Question: According to the figure, is the described quantity increasing or decreasing?
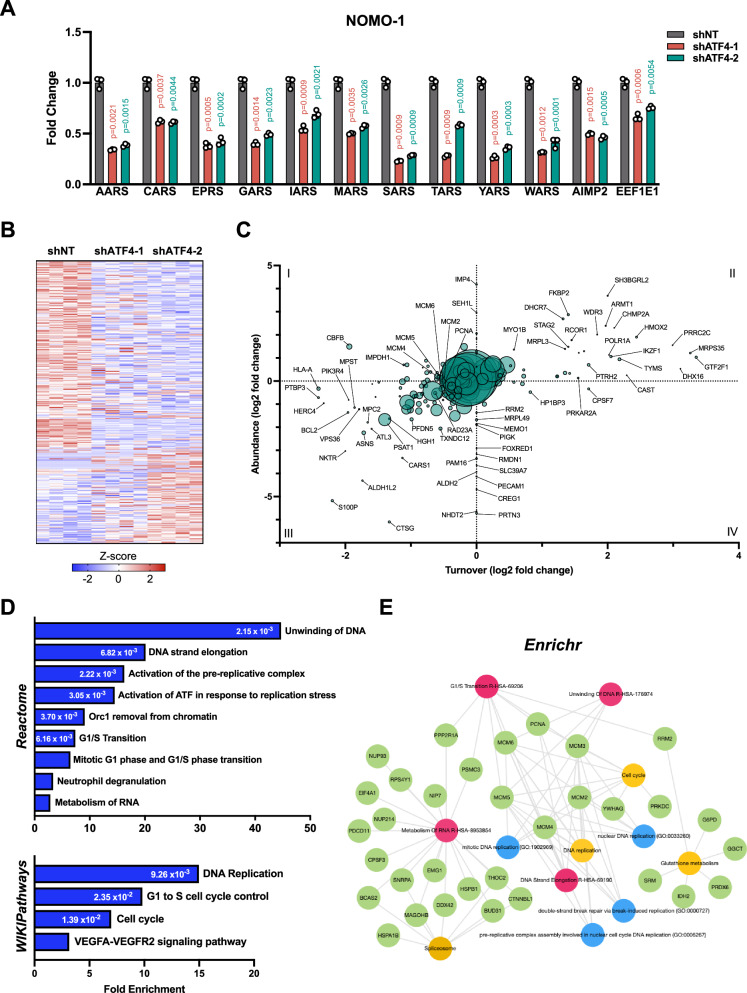
Answer: decreasing